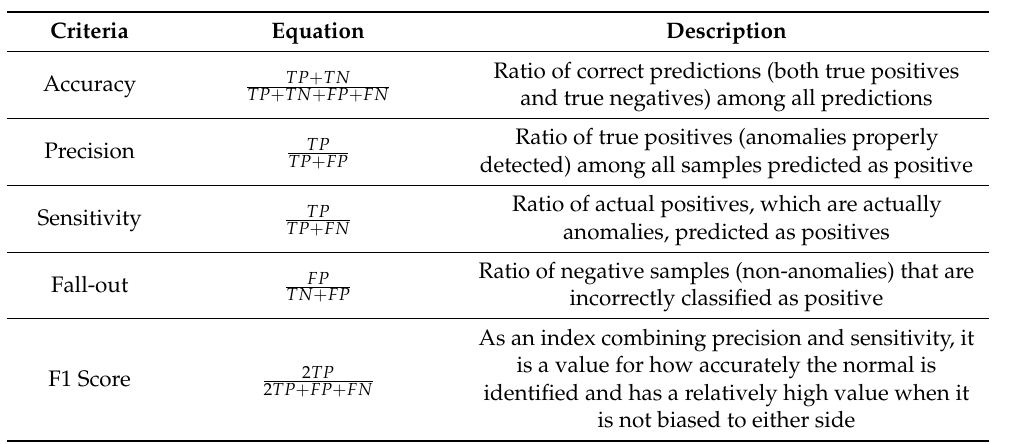
Table 3. Evaluation